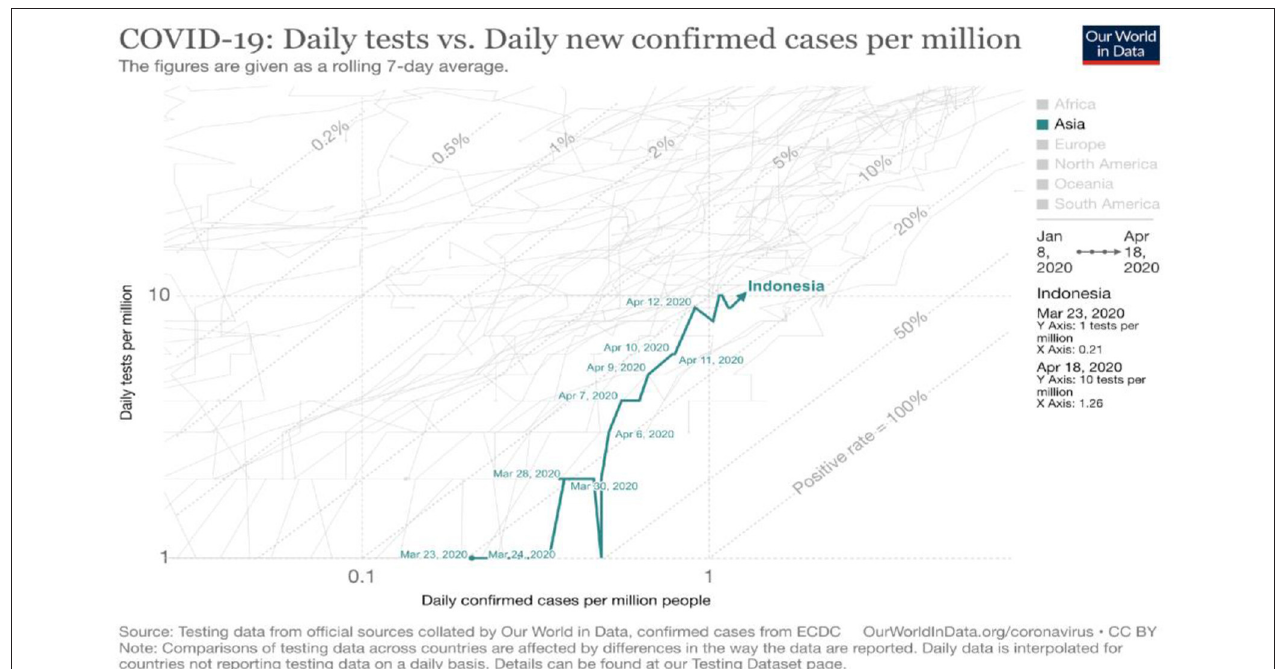
FIGURE 2 | COVID-19 daily tests vs. daily new confirmed cases [Source: (26), Oxford University 2020].